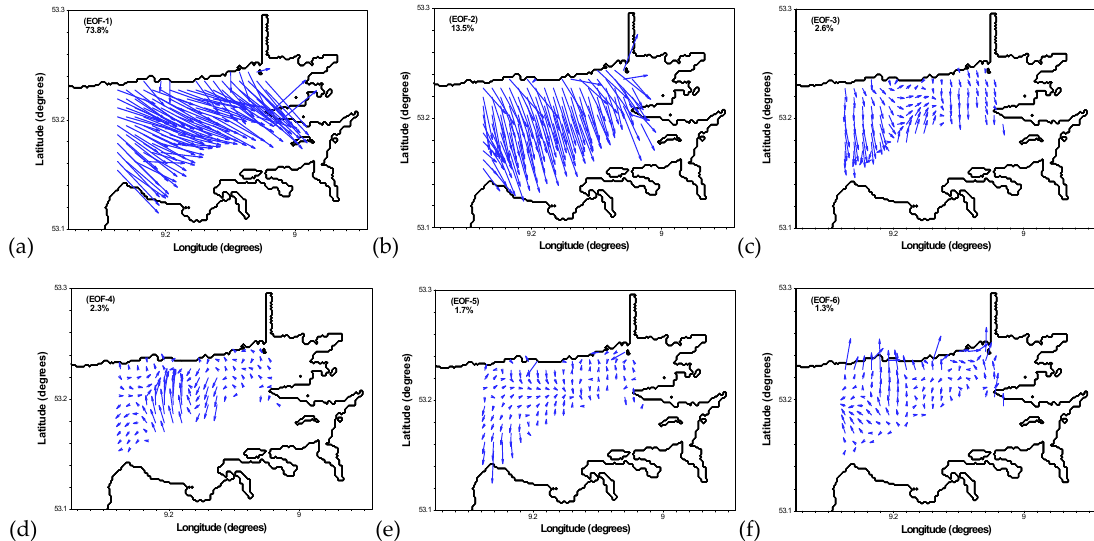
Figure 8. Spatial empirical orthogonal function (EOF) modes of model results (subfigures ( a )–( f ) indicates the first to the sixth EOF eigenvector modes, respectively).